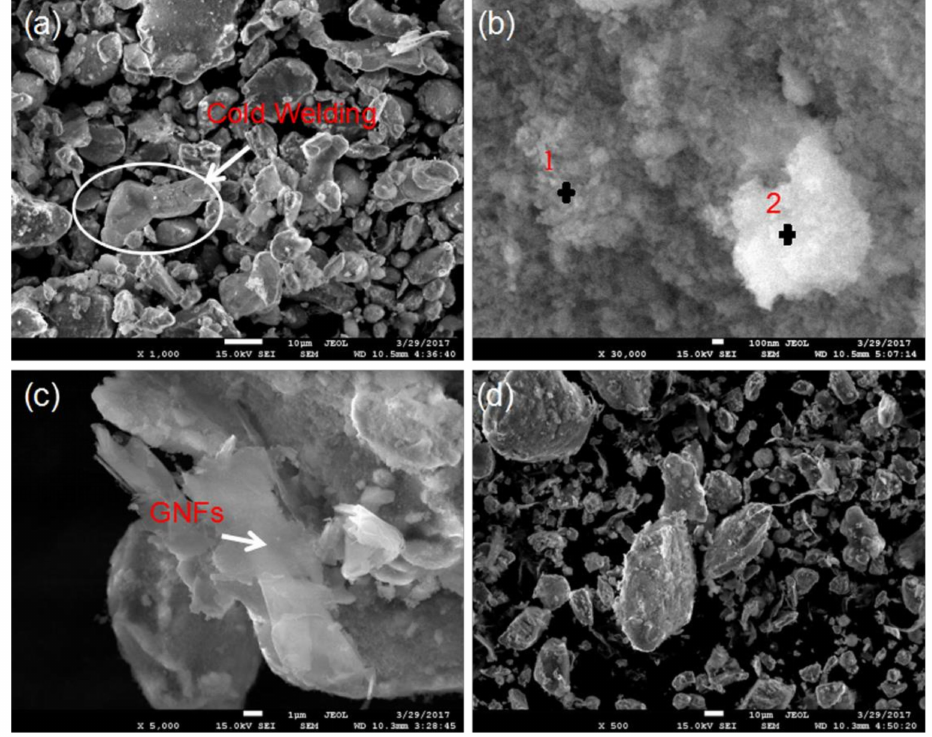
Figure 3. ( a , b ) SEM micrographs of the 0.5-GNFsnanocomposites in different regions; and ( c , d ) SEM